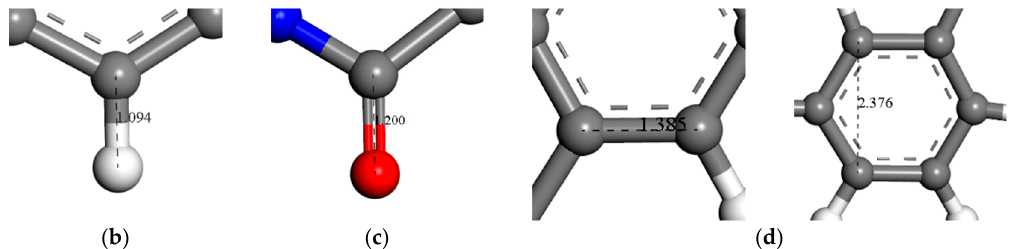
Figure 9. Schematic diagram of local structure ( a ) Covalent bond between N and H; ( b ) Covalent bond between C and H; ( c ) Covalent bond between C and O; ( d ) Distance between C atoms on benzene ring.